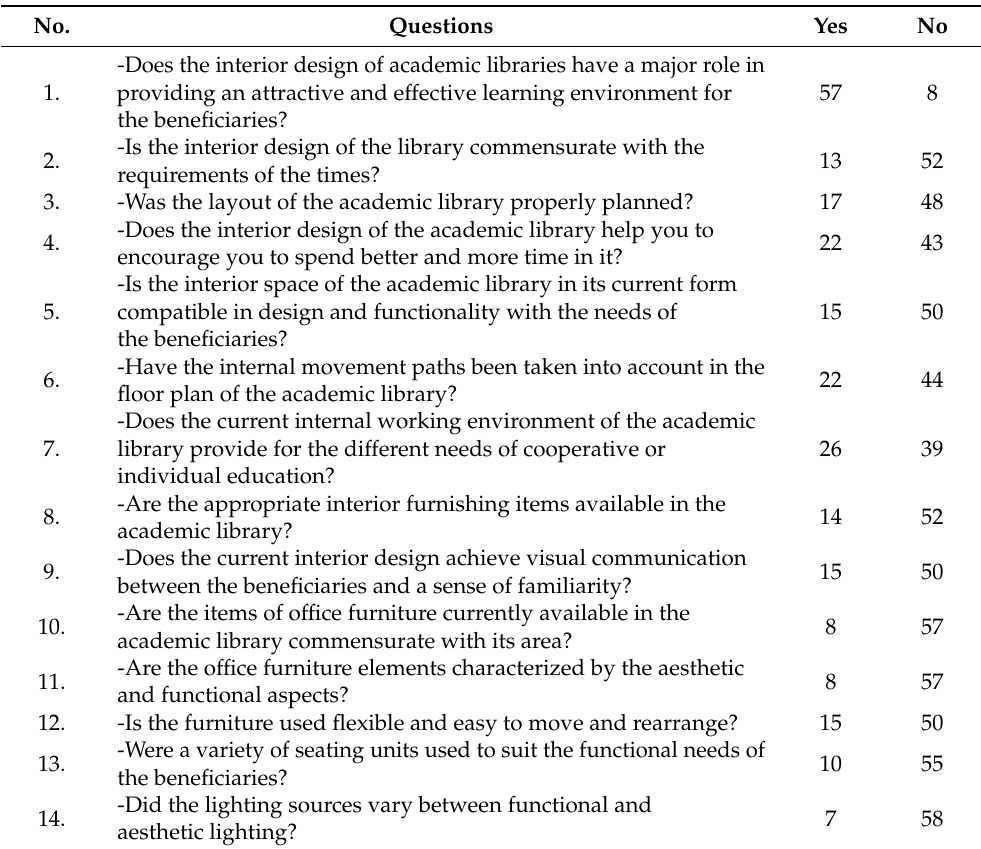
Table A1. Opinion poll on the current interior design of the Academic Library, College of Education, King Faisal University from the point of view of the